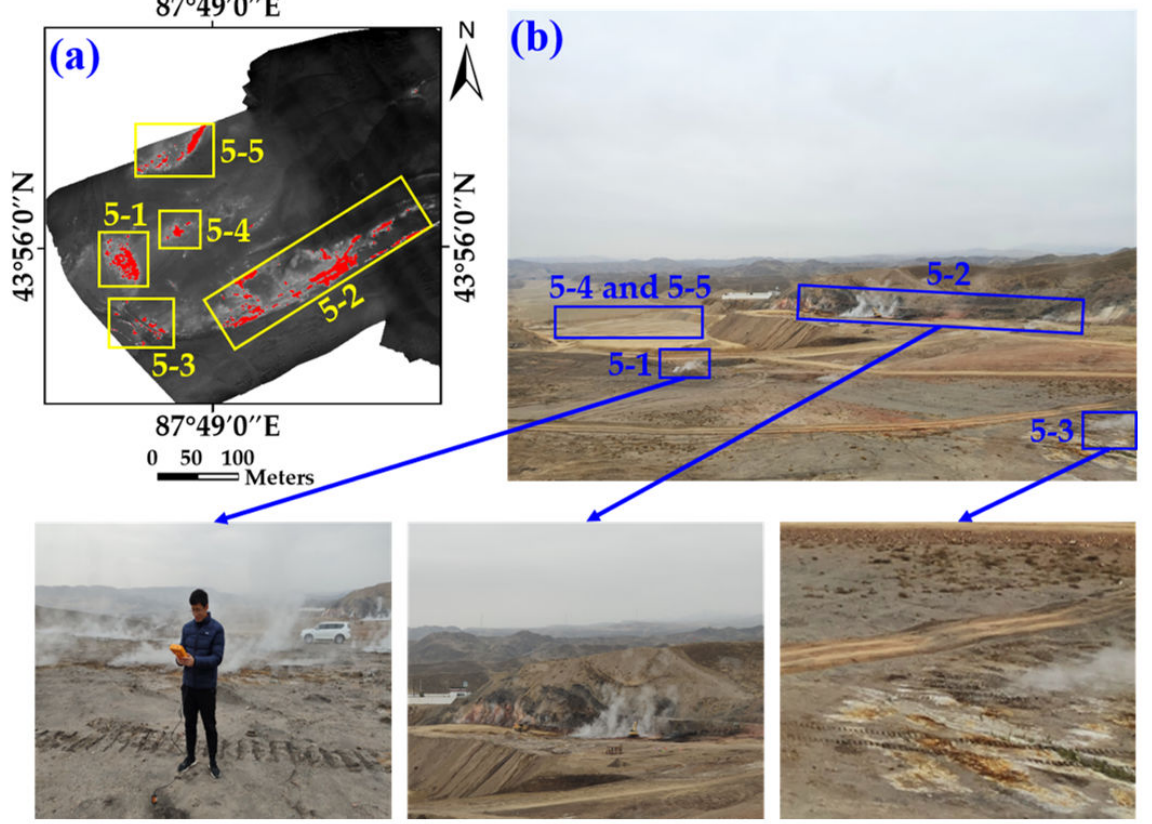
Figure 10. Field verification of UAV extraction result: ( a ) coal fire areas extracted from UAV data and ( b ) field